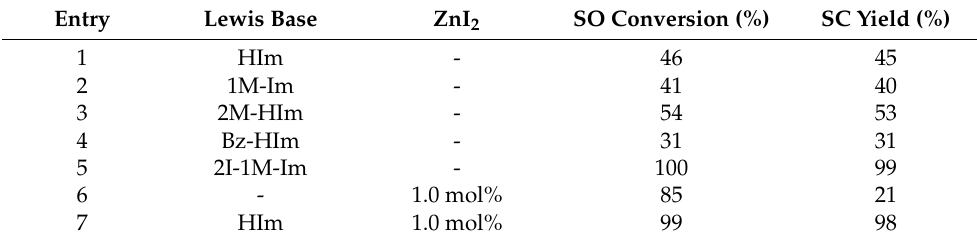
Table 1. Variation of the catalyst for the CO 2 cycloaddition into styrene oxide. Entry Lewis Base ZnI 2 SO Conversion (%) SC Yield (%) 1 HIm - 46 45 2 1M-Im - 41 40 3 2M-HIm - 54 53 Bz-HIm - 2I-1M-Im HIm